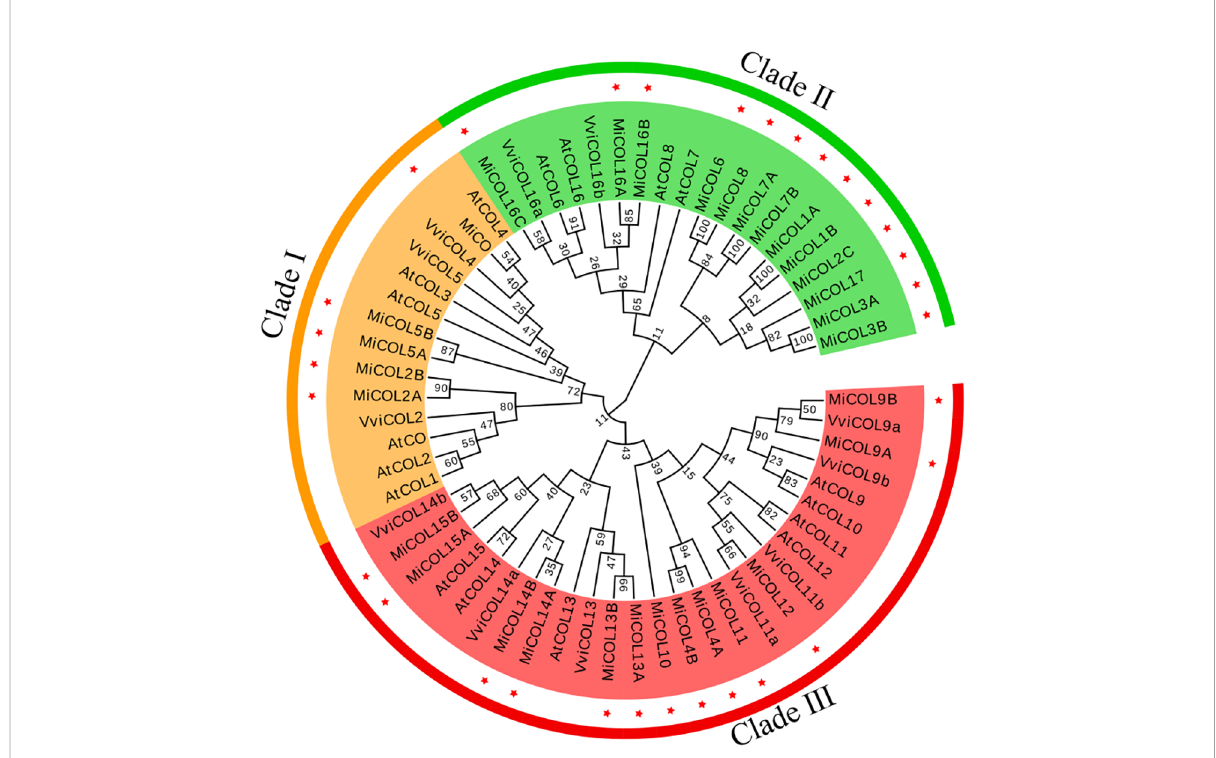
FIGURE 1 Phylogenetic tree of COL proteins in mango and Arabidopsis . Clades I, II and III are marked in yellow, green and red, respectively. Red stars represent mango family genes. The gene IDs of the COs/COLs in Arabidopsis are listed in Supplementary Table